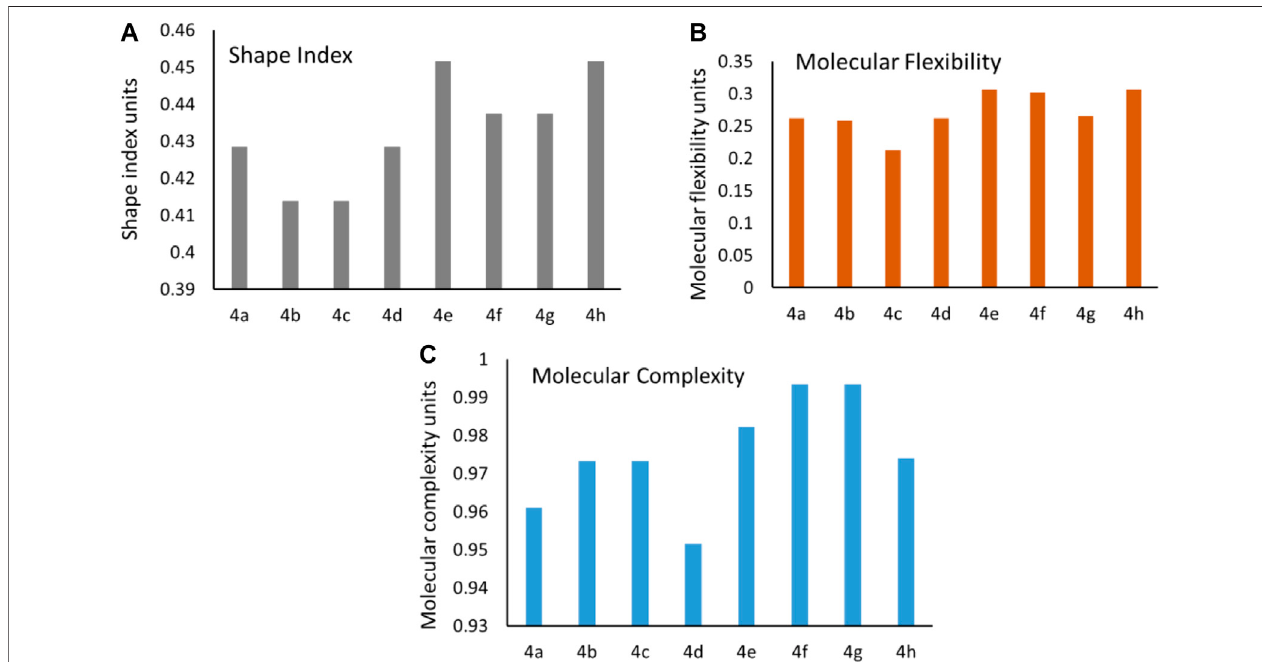
FIGURE 6 | Predicted values of the (A) shape index, (B) molecular fl exibility, and (C) molecular complexity for the synthesized molecules.